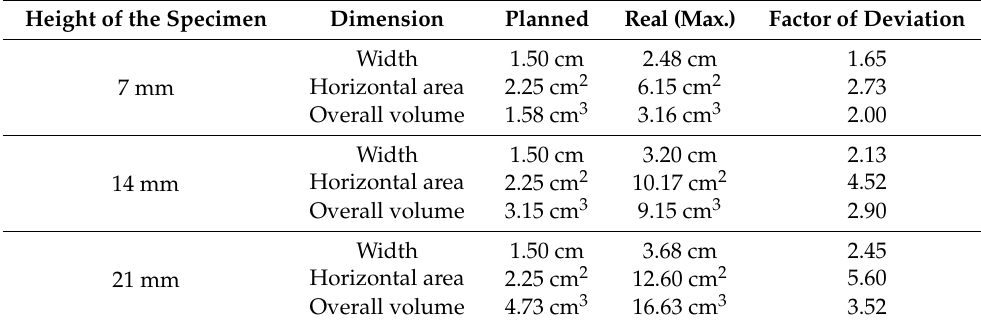
Table 3. Dimensions of the produced rectangular cuboids and their comparison with those of the planned